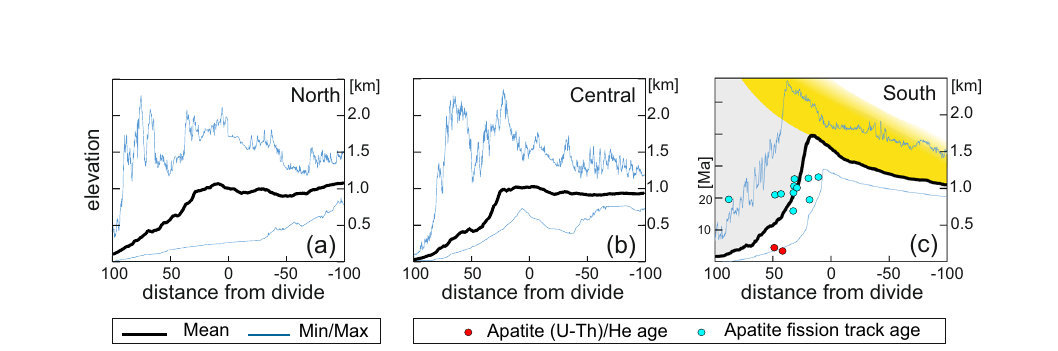
Fig. 3 | Curved topographic swath pro fi les 21 across the Red Sea margin. Swaths are forthe northern(in a),central(in b) and southernpart(in c) of the escarpment and are derived from the SRTM3_V4 data 36 . Locations of pro fi les are shown in Fig. 1a. The pro fi le for the study region is shown in c and also includes the low